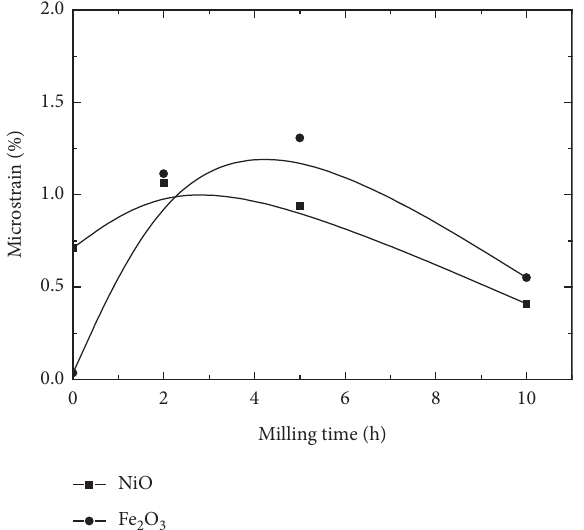
Figure 7: Measured micro-strain in the milled powders.